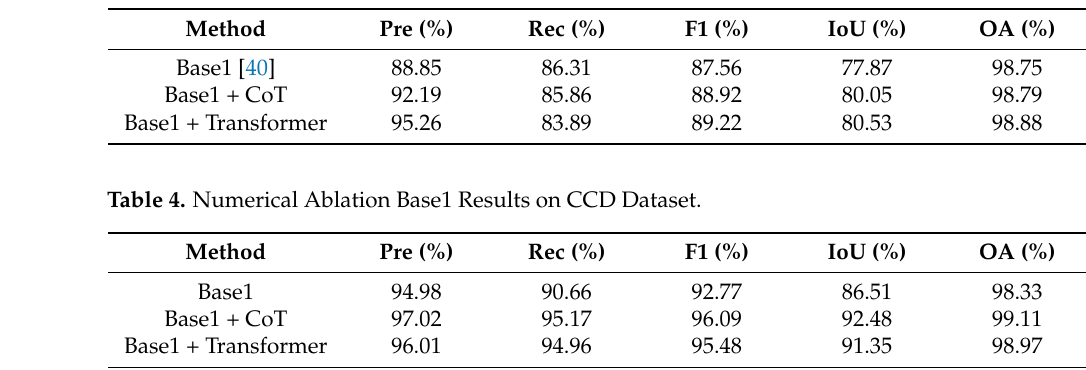
Figure 9. Visualization results on the CCD dataset. ( a ) The images at time1. ( b ) The images at time2. ( c ) The ground truth. ( d ) The results of IFN. ( e ) The results of SNUNet. ( f ) The results of STANet. ( g ) The results of BiT. ( h ) The results of MSPSNet. ( i ) The results of DMMSTNet. Table 3. Numerical Ablation Base1 Results on LEVIR-CD Dataset.